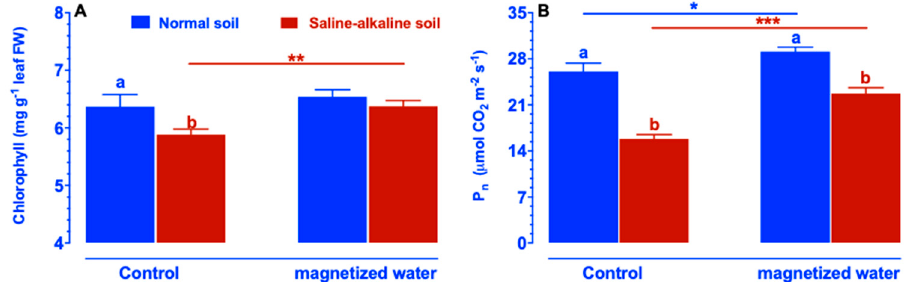
Figure 2. Foliar chlorophyll concentration ( A ) and photosynthetic rates ( B ) of Nipponbare plants cultivated in normal and saline–alkaline stress soil irrigated with magnetic and non-magnetic water. Treatments were as described in Figure 1. Means with different letters are significantly different ( p < 0.05) within the same treatment. Asterisks indicate significant differences between control and saline–alkaline stress of the same genotype, as determined by Student’s t -test (* p < 0.05, ** p < 0.01, *** p <